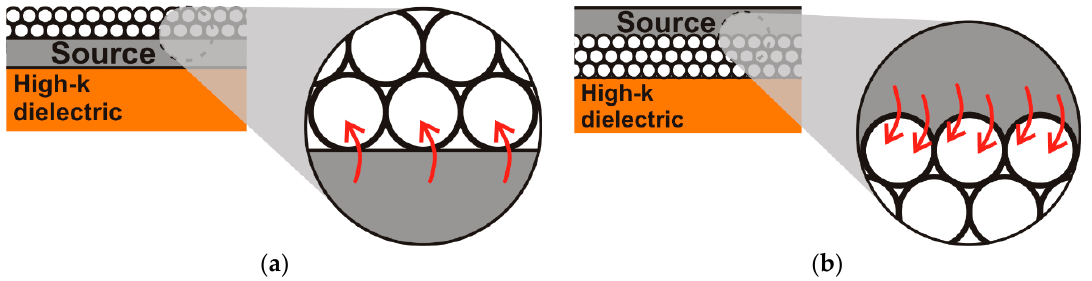
Figure 4. Detailed of the contact between the source (drain) electrode and the nanoparticulated layer in ( a ) inverted coplanar and ( b ) inverted staggered setups showing the charge carrier injection.